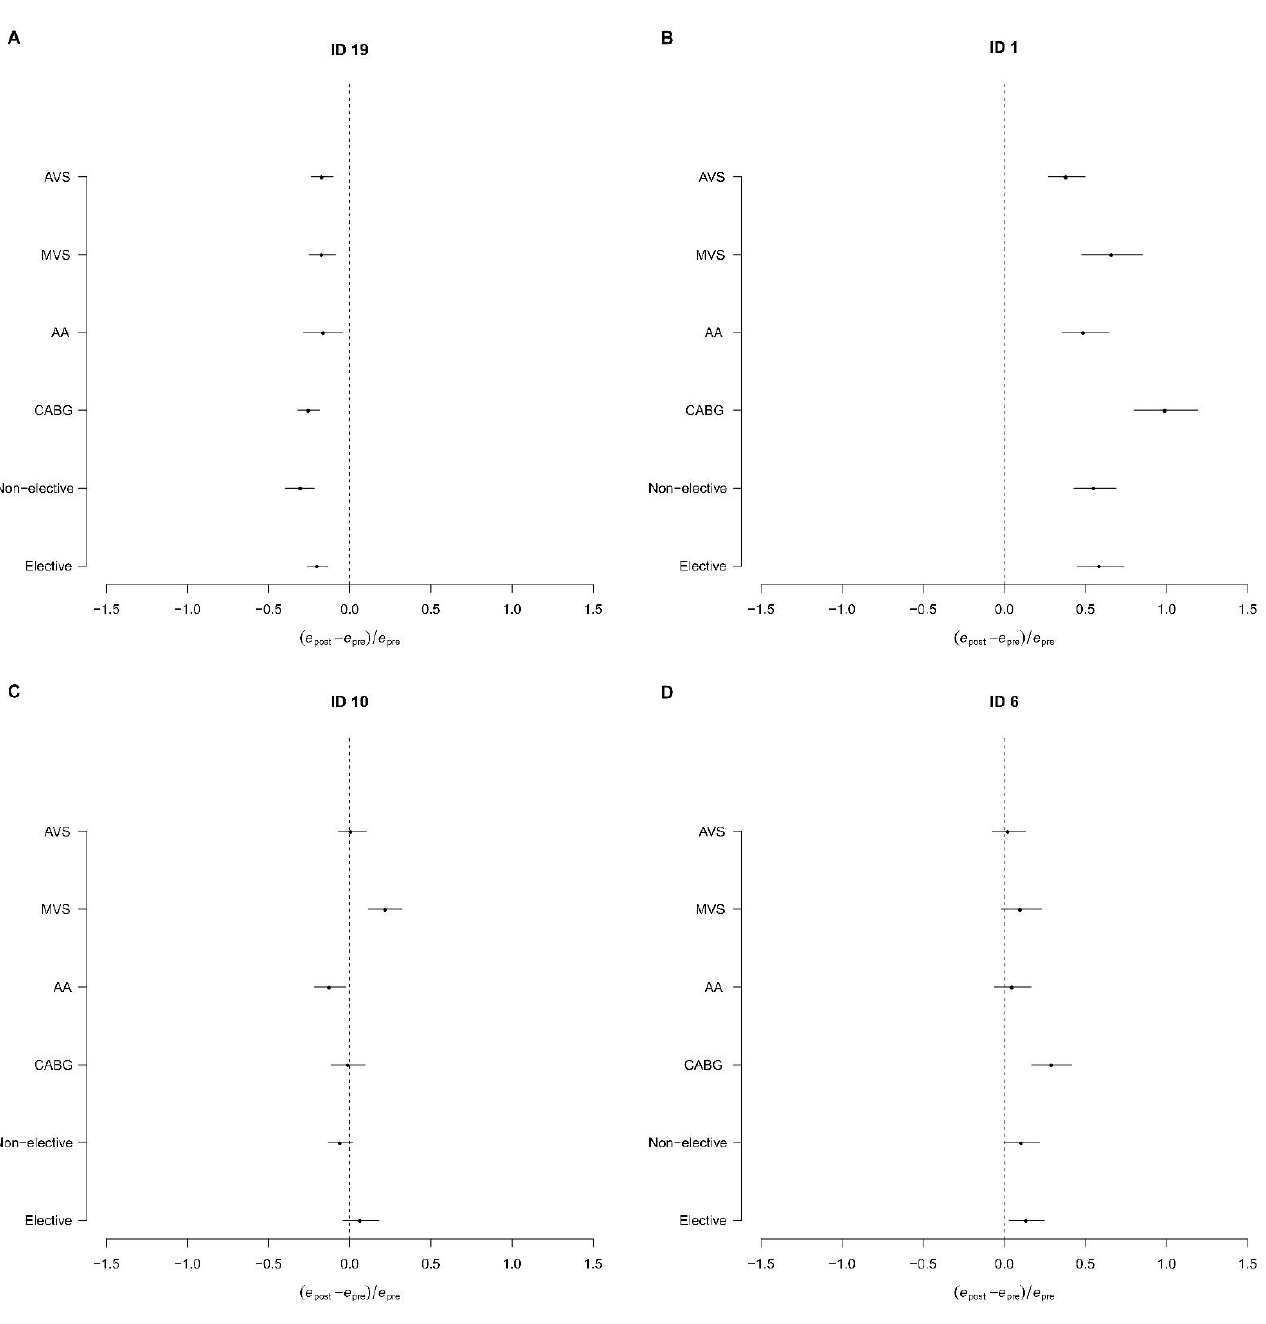
Figure 4. Intraoperative performance d = ( e post − e pre )/ e pre . Application of the double-fold model (see Methods section and caption of Figure 3). ( A ) In center 19, surgical activity reduces mortality in all groups; ( B ) in center 1, surgical activity increases mortality in all groups; ( C ) mixed effects on mortality in center 10: MVS was responsible for the overall increase in mortality; ( D ) increased risk of deaths only in CABG patients in center 6. AVS: aortic valve surgery; MVS: mitral valve surgery; AA = ascending aorta; CABG: Coronary Artery Bypass Grafting.